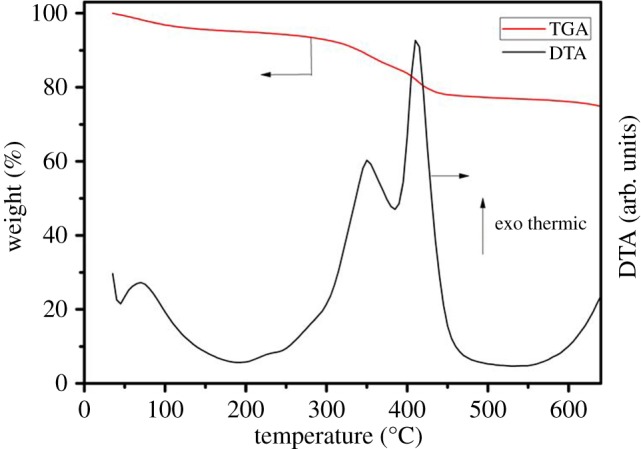
TGA of the La0.6Sr0.4CoO3 perovskite catalyst.